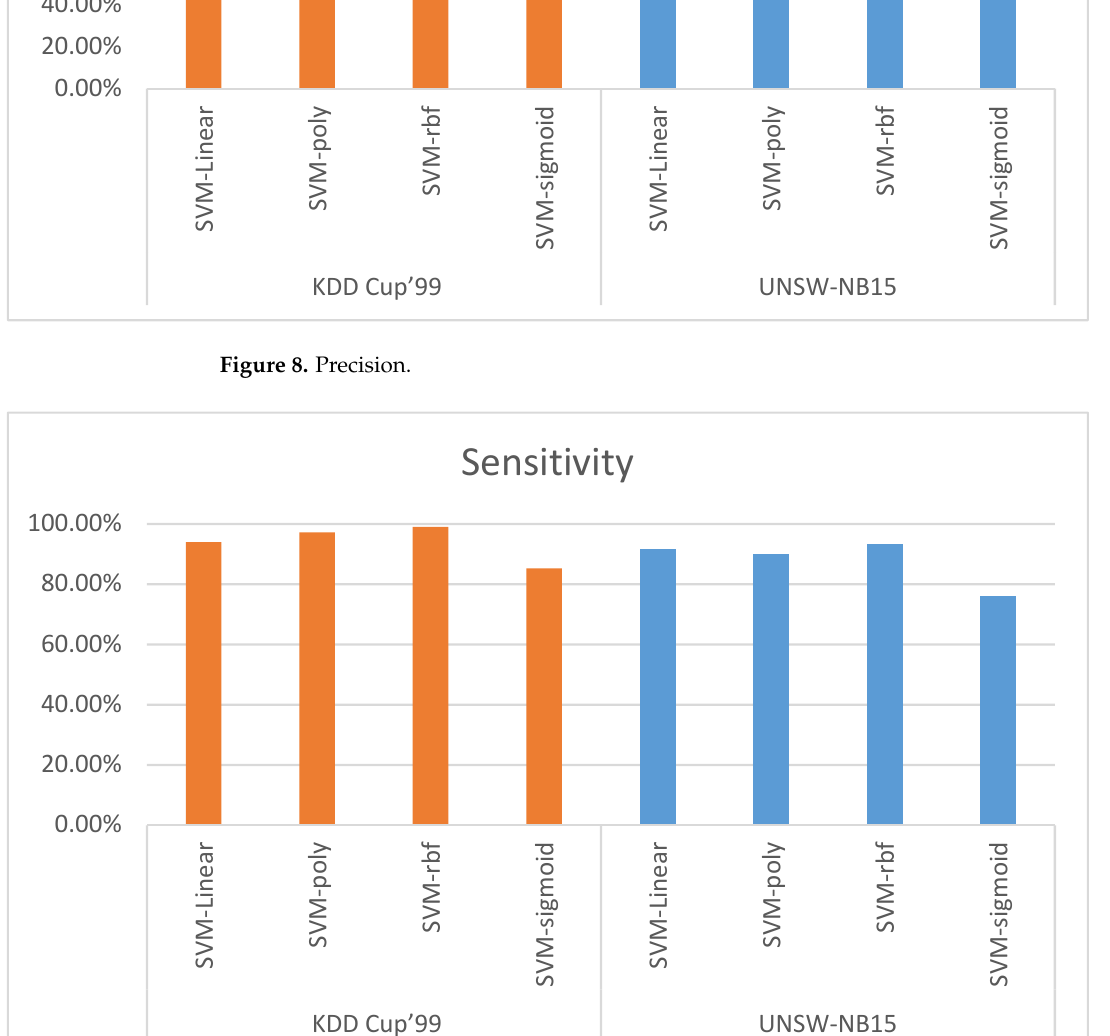
Figure 8. Precision